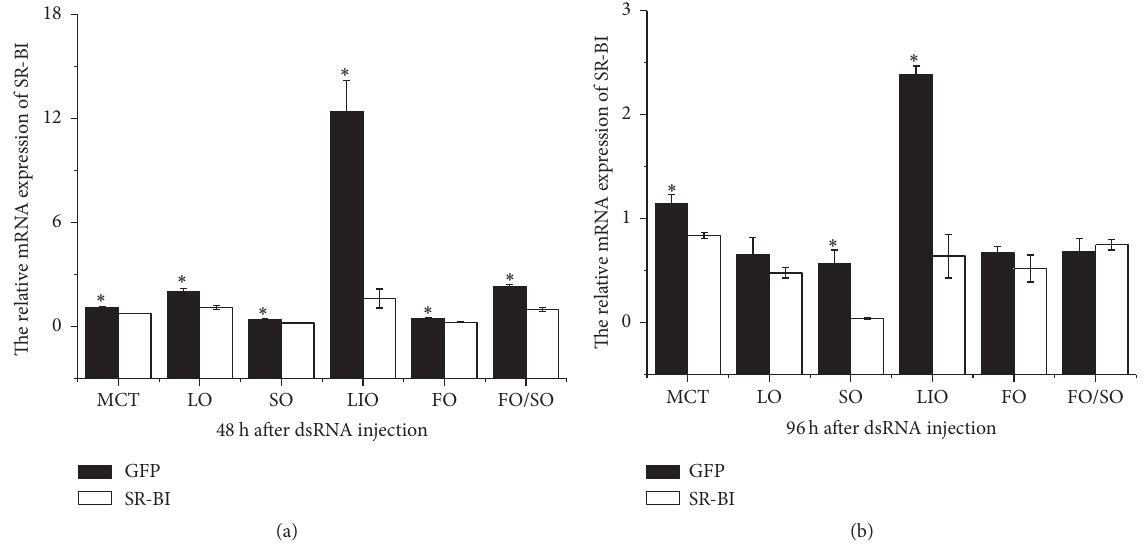
Figure 6: Real-time quantitative PCR analysis of the MnSR-BI transcript expression in the hepatopancreas of M. nipponense injected with either MnSR-BI or GFP dsRNA. Samples were obtained 48 h (a) and 96 h (b) after dsRNA injection and analyzed by real-time qRT-PCR. Bars indicate mean ± SD ( 𝑛 = 3 ). ∗ 𝑃 < 0.05